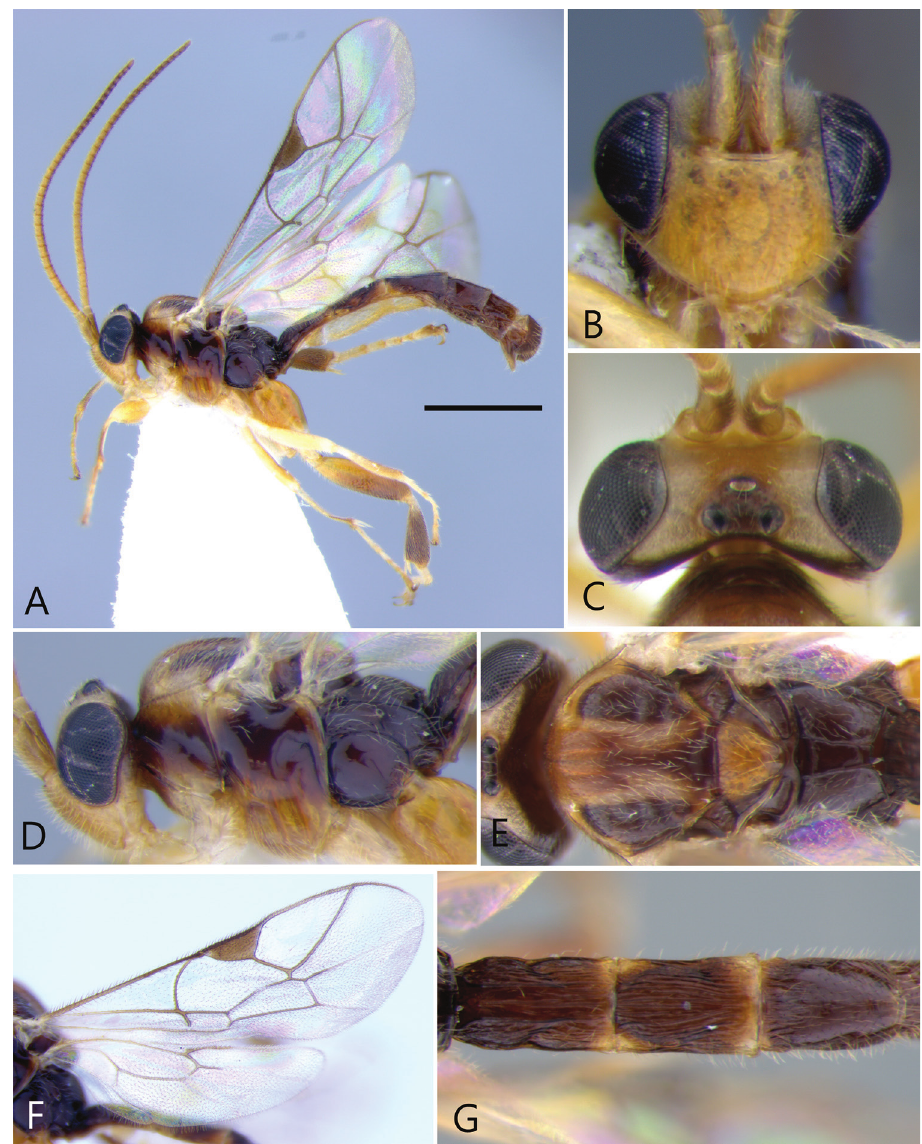
Figure 13. Orthocentrus pulchellus sp. nov. Holotype. A Habitus in lateral view B head in frontal view C head in dorsal view D head and mesosoma in lateral view E mesosoma in dorsal view F wings G first to third tergites in dorsal